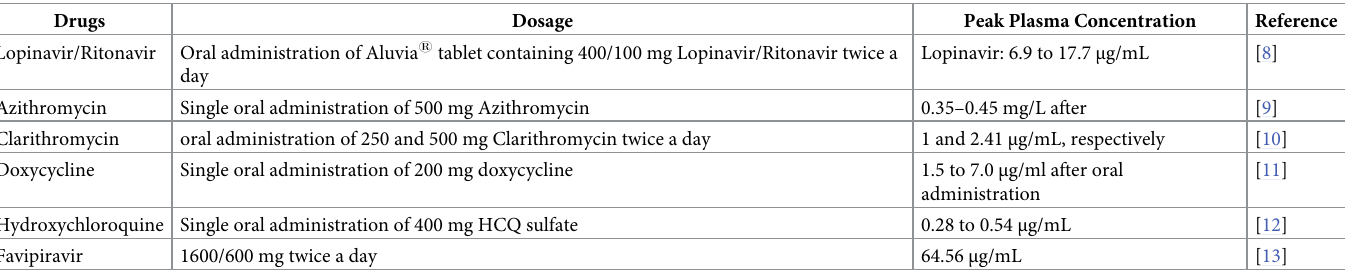
Table 1. Peak plasma concentration of Lopinavir/Ritonavir (LOPIRITO), Azithromycin (AZI), Clarithromycin (CLA), Doxycycline (DOXY), Hydroxychloroquine (HCQ), and Favipiravir (FAVI) after a single oral administration of the drug.